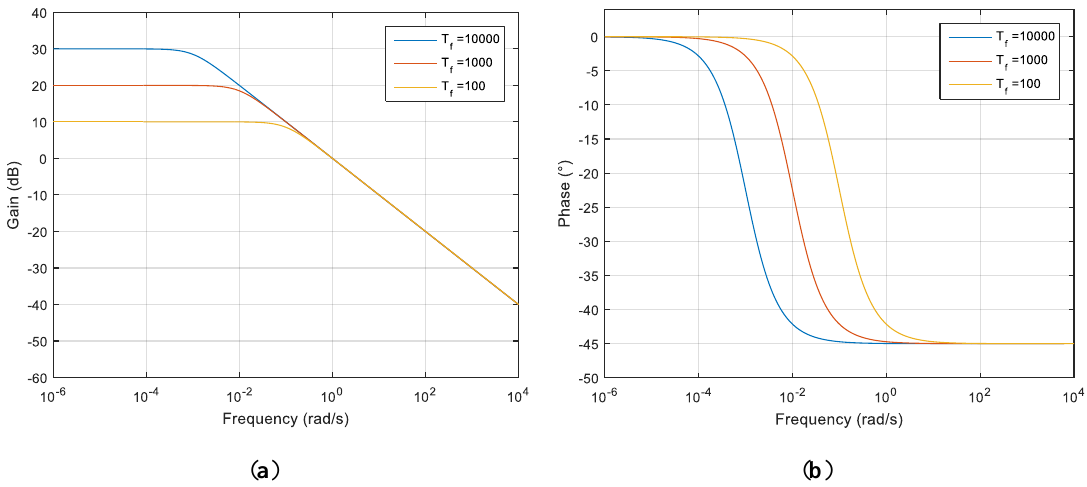
Figure 2. Gain ( a ) and phase ( b ) diagrams of integral I(s) for various values of T f and ν = 0.5.